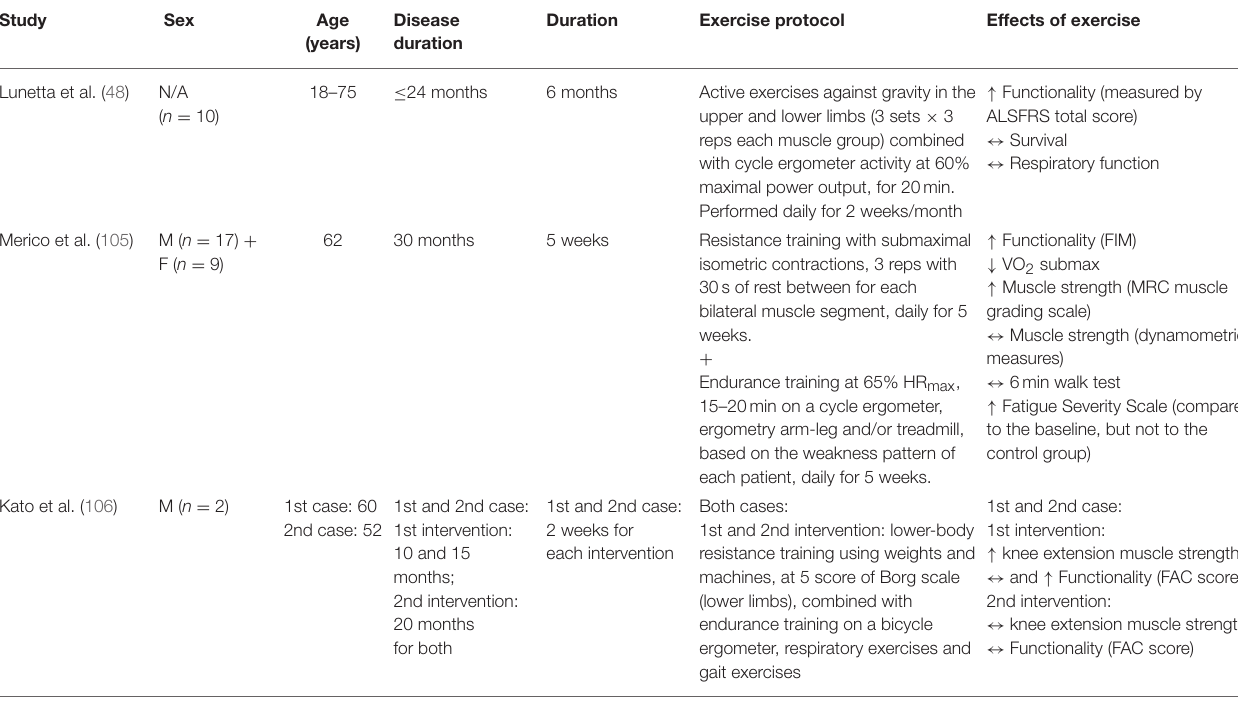
TABLE 5 | Summary of the effects of concurrent endurance and resistance training in ALS patients. Study Exercise protocol Effects of